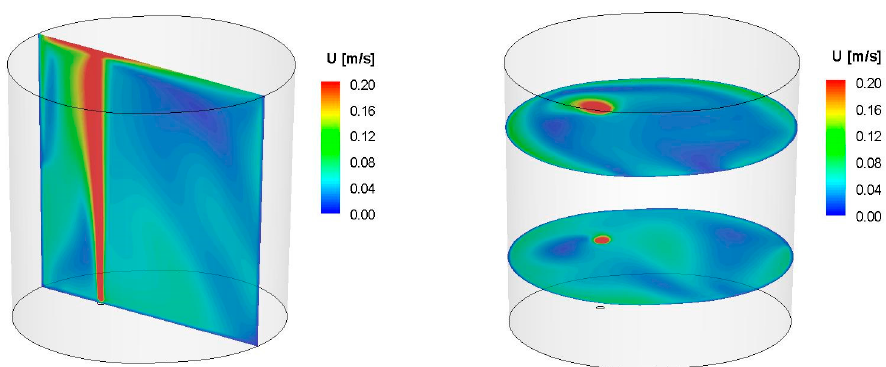
Figure 5. Contour maps of liquid steel velocity in selected control planes for simulation Sim_3 (density = 7004 kg , Ar flow = 25 L/min).